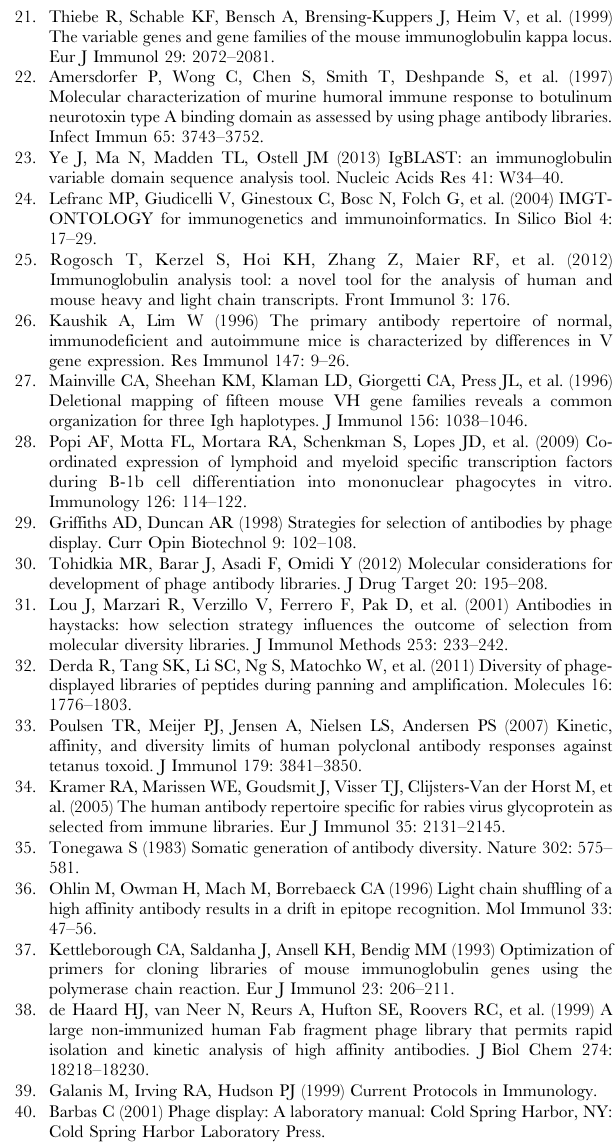
Table S3 PCR Primers for the Amplification of